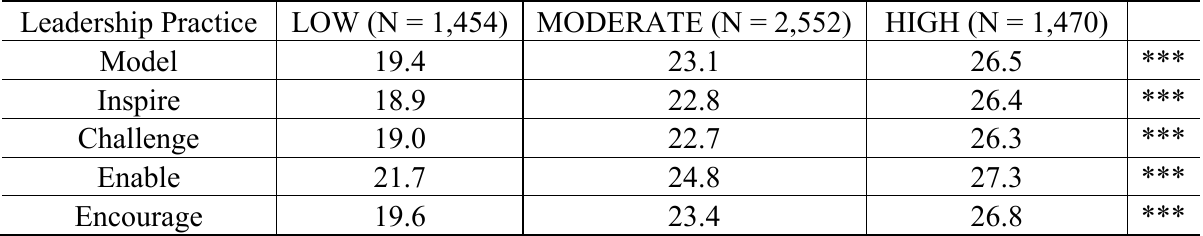
Table 11b. Comparisons by Enhanced Positive Work Outcome